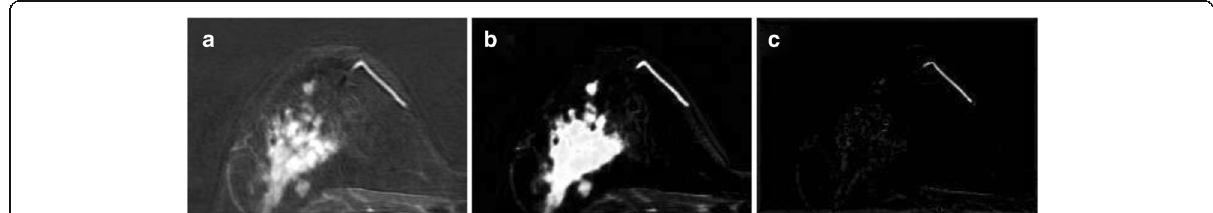
Fig. 6 Result from the vesselness filter. a The subtracted image at the first post-contrast time point. b Lesion membership matrix obtained by FCM clustering. c Response of the vesselness